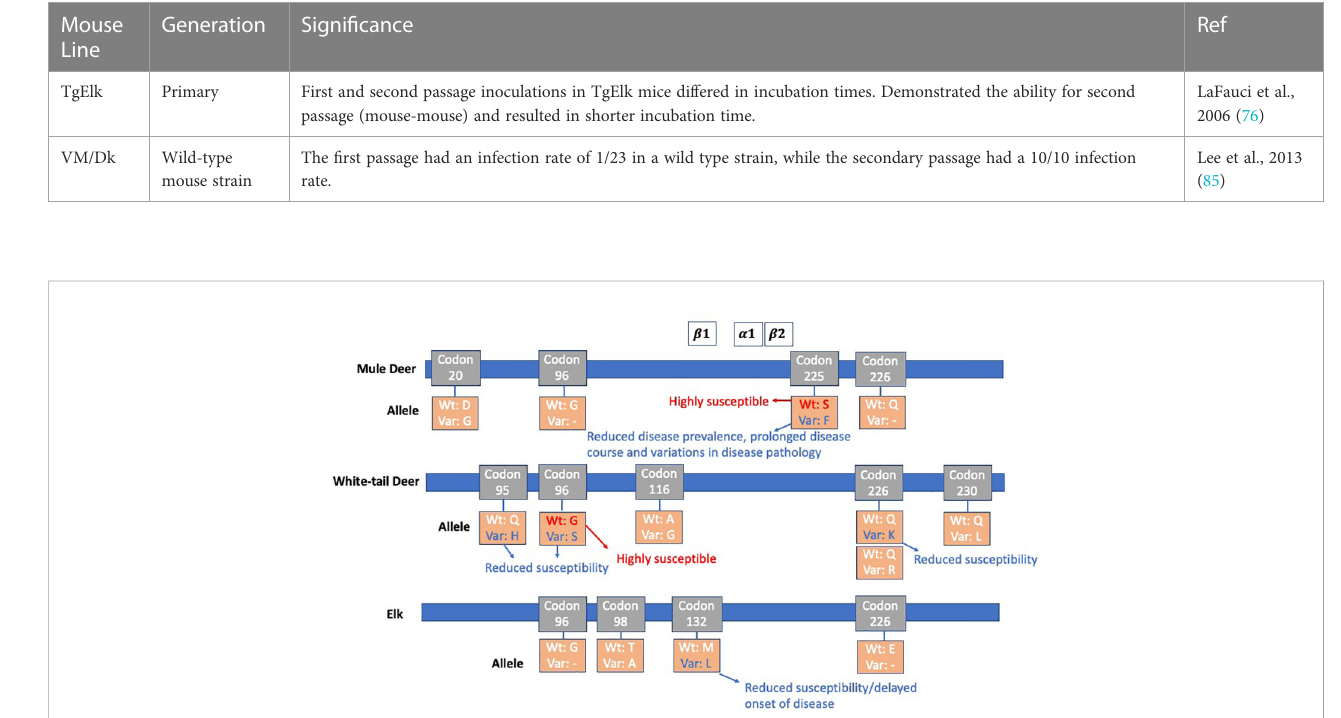
FIGURE 1 PrP Codon Polymorphisms among Mule Deer, White-tail Deer, and Elk: CWD susceptibility, disease onset, and pathology have been seen to be affected by polymorphisms in the cervid Prnp. b 1, a 1 and b 2 and molecular structures are shown at their approximate location in reference to the codons (88). Mule deer have a polymorphism at position 225, referred to as 225F, which shows reduced disease prevalence, prolonged disease course, and variation in disease pathology. White-tailed deer contain many PRNP variants, several of which affect susceptibility. Codon 226 has a variant 226K, in which CWD susceptibility is reduced. In elk, codon 132 has a critical role in susceptibility and onset of disease. Animals expressing the 132M variant is overrepresented in both free-ranging and farmed elk positive for CWD. Those with 132L have a reduced rate of CWD and a delayed onset of disease progression.